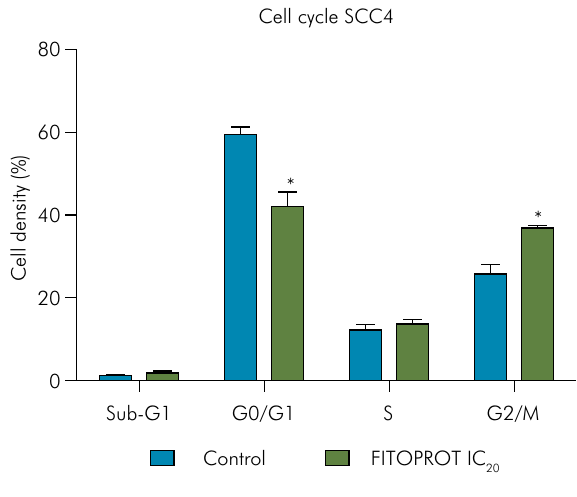
Figure 3. Distribution of SCC-4 cell density (%) in each phase of the interphase (sub-G1, G0/G1, S, and G2/M). *Statistically significant difference between groups (ANOVA test).